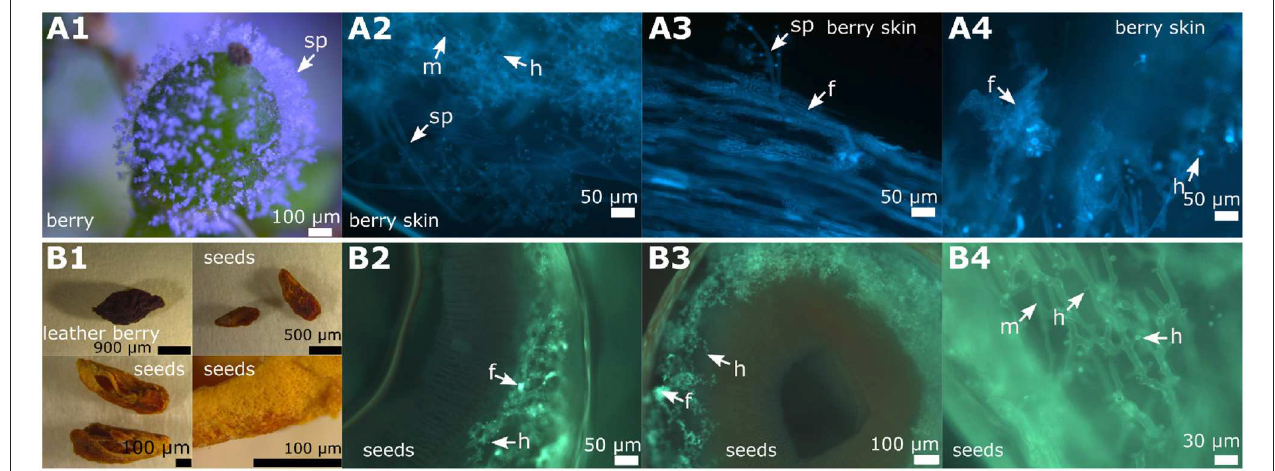
FIGURE 8 | Overview of DM infected berries and seeds in grapevines. Examples of microscopic images from the different stages of a berry infection (cultivar “Riesling”). (A1–A4) The young berries with emerging sporangiophores (A1) showed the formation of fan-shaped hyphae in the microscopic image (A2–A4) . The formation of haustoria by the regular, but also by the fan-shaped hyphae, is clearly recognizable. (B1–B4) The first picture (B1) shows a berry that has been severely damaged by the pathogen and seeds derived from it. The seeds were separated and partly cut longitudinally and partly cut transversally. The microscopic images (B2–B4) represent cross sections of the seeds. Infiltration by the pathogen by typical mycelium (shown in green) is evident with all the typical pathogen elements. The pathogen spread along the inner side of the exotesta. The last microscopic picture (B4) shows a longitudinal section through the seed. m, mycelium; f, fan-shaped hyphae; sp, sporangiophores; h,